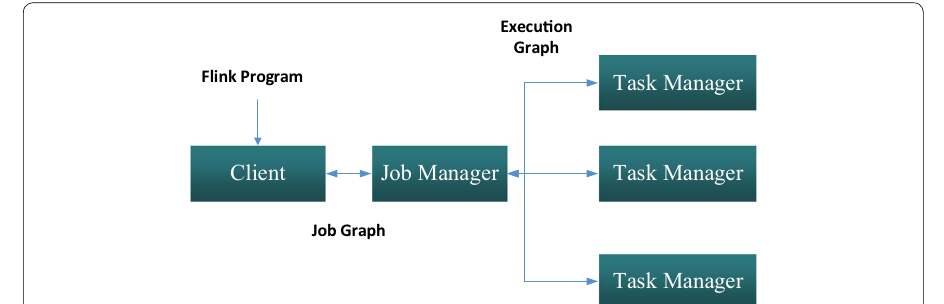
Fig. 5 High level architecture of Apache